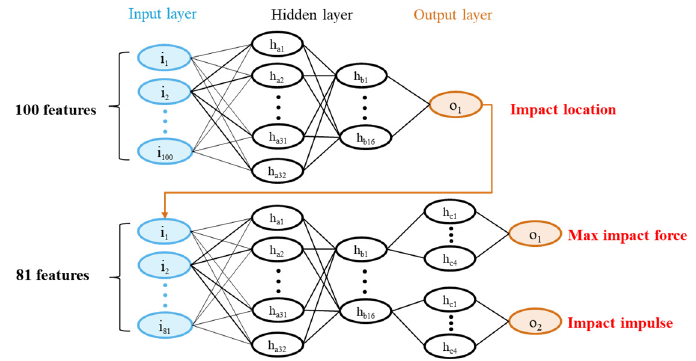
Figure 9. Suspension bridge in Lake of the Woods, Mahomet, IL. 4.2. Finite Element Modeling and Updating A bridge FE model created by Hoskere et al. [26] in ABAQUS is employed as the initial FE model. Severe corrosion was found in many components of the real bridge, such as main girders, braces, gusset plates for connections, beams, and columns in the bridge tower. Accordingly, model updating must be performed to match the dynamic behavior between the FE model and the real bridge. The main strategy of model updating is to adjust Young’s modulus, the geometry of the bridge components, as well as the density of wood decks, which changes when it becomes wet. Before model updating, all the pa- rameters are examined in the sensitivity analysis to select the most appropriate ones. As shown in Figure 10, when the parameters decreased to 90% of the initial level, the sensi- tivity of the main parameters is measured by the change of six main natural frequencies. Note that these six natural frequencies are observable during field tests, including mode 2, 3 and 5 in vertical direction and mode 1, 2 and 3 in horizontal direction, as shown in